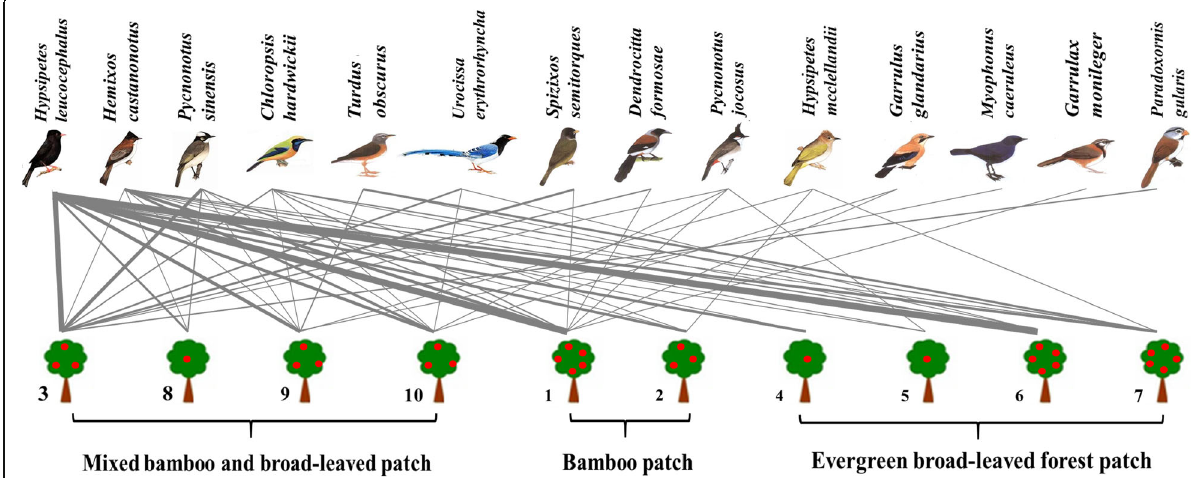
Fig. 2 A network approach showing the seed removal interaction between frugivorous birds and different individuals of Taxus chinensis in yew ecological garden, Fujian Province, southeast China. Number 1 – 10 represented different individuals of studying trees. Thicker lines represent increased strengths of seed removal. Red dots in the trees represent the fruit amount, 1 dot represent seeds < 15,000; 3 dots represent 15,000 < seeds < 20,000; 5 dots represent seeds > 20,000. The logos of bird species were cited from A Field Guide to the Birds of China